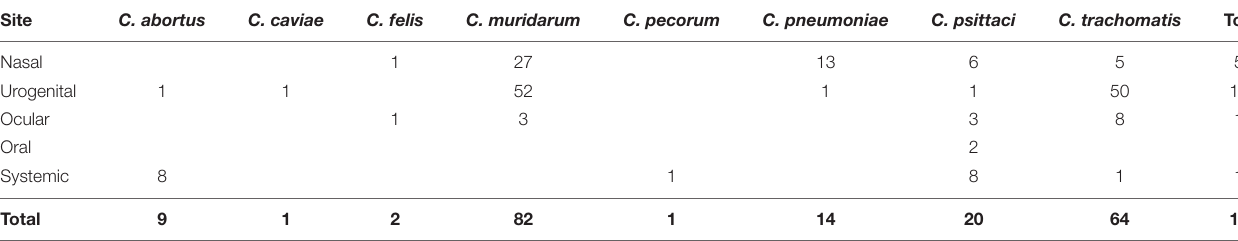
TABLE 5 | Challenges based on Chlamydia species and anatomical